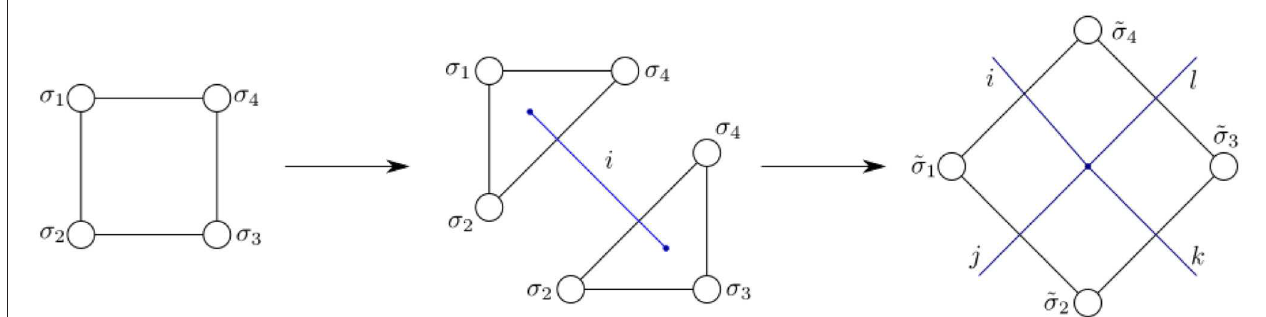
FIGURE 11 | Illustration of decorated tensor networks. Splitting an amplitude, here for four Ising spins, via a singular value decomposition generically gives rise to additional indices. These indices are understood as more general boundary data and are encoded in a tensor network dual to the lattice. This network is thus “decorated” by the remaining